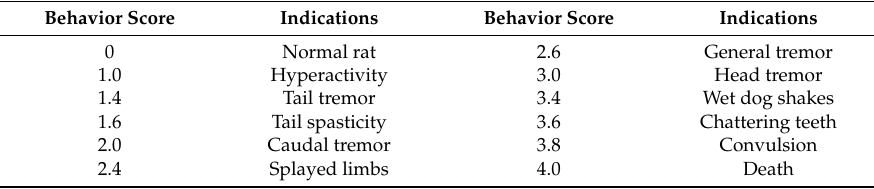
Table 3. Withdrawal behavior